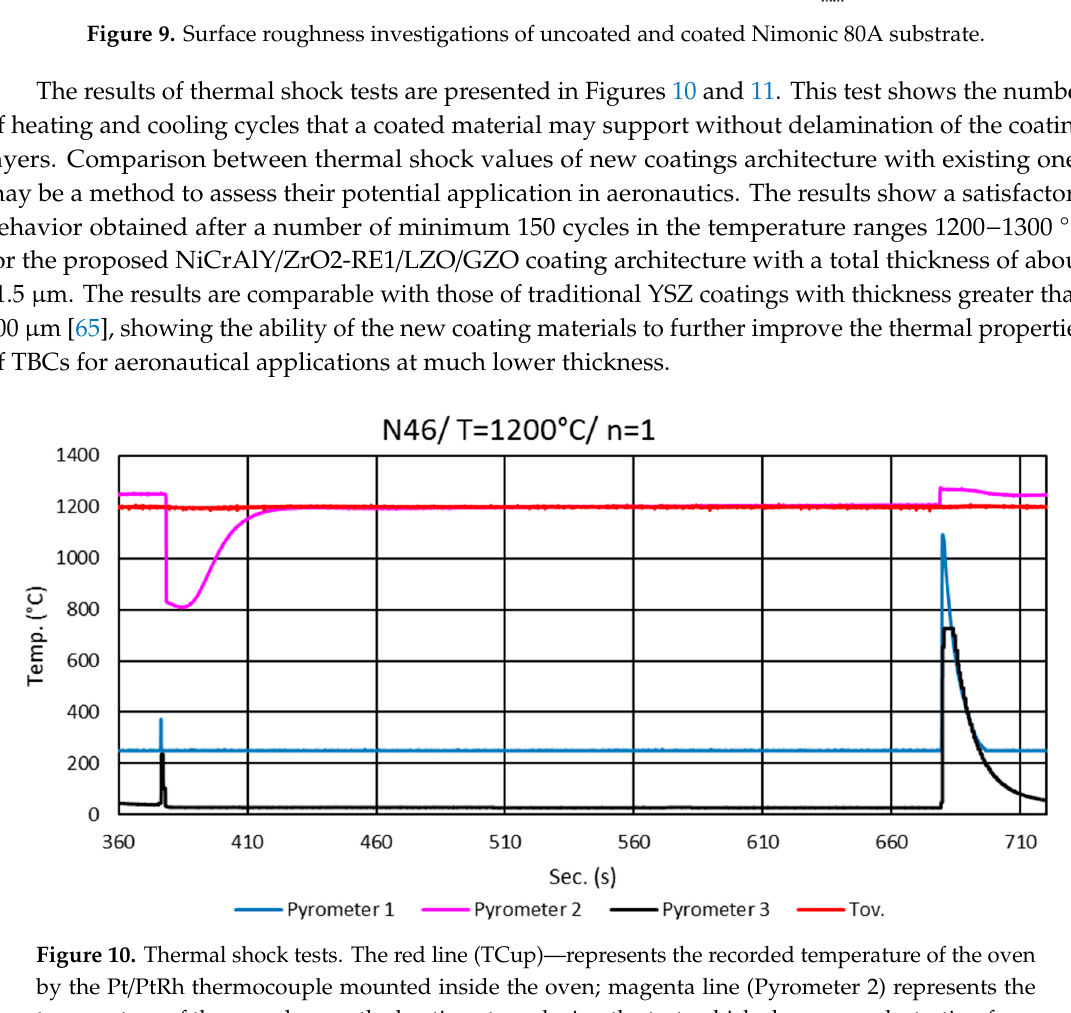
Figure 9. Surface roughness investigations of uncoated and coated Nimonic 80A substrate.